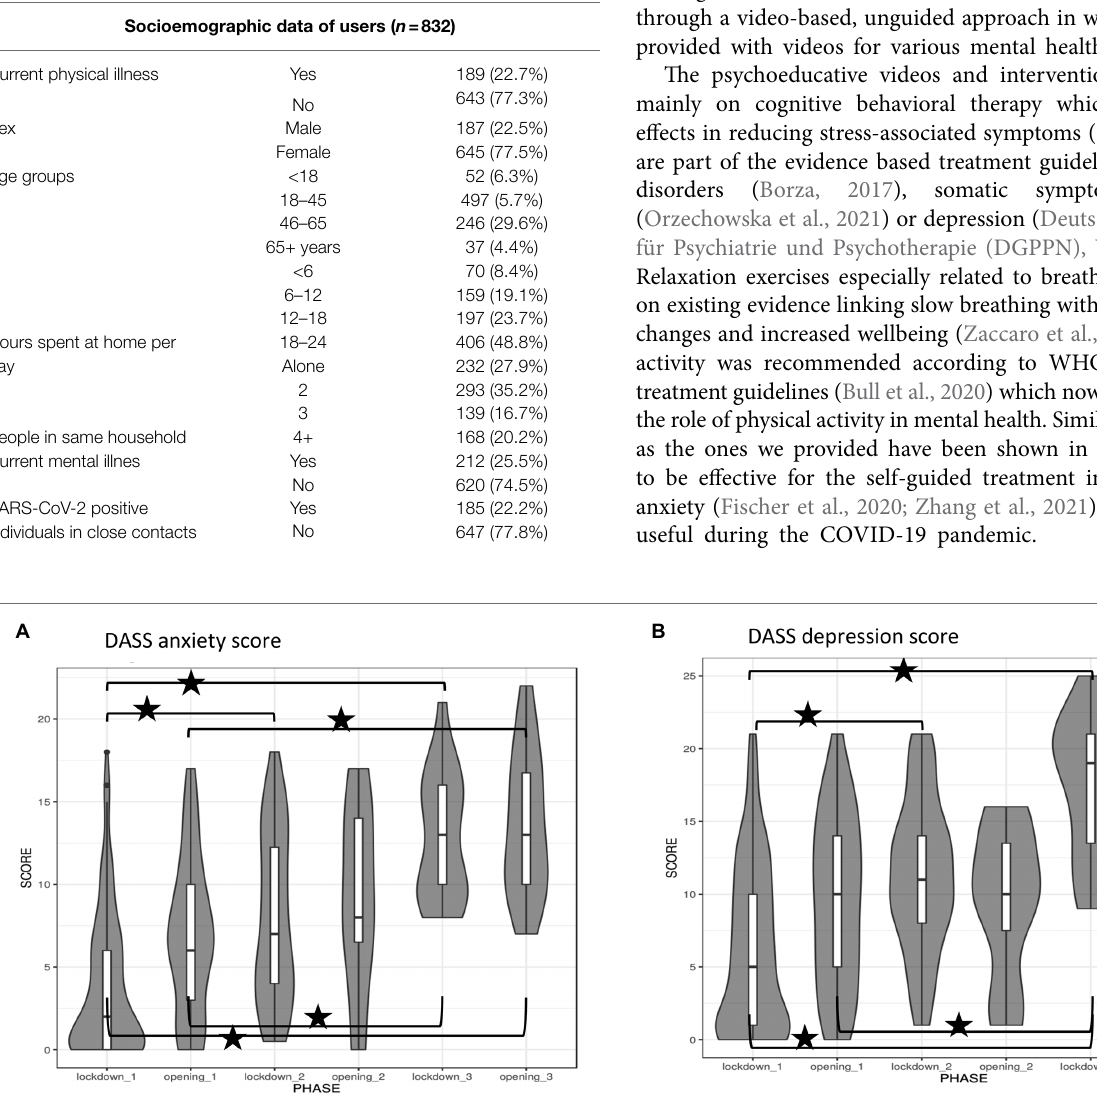
FIGURE 5 | Example of psychometric self—rating questionnaires collected by the online mental health self-help platform. Data are shown as median and 25% quantile range. Significant differences between pandemic phases are indicated by asterisks ( p < 0.01 adjusted for multiple comparisons). (A) DASS, depression anxiety stress scale—anxiety score. (B) DASS, depression score.